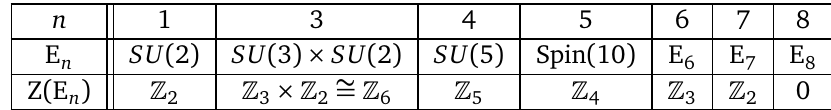
groups and their n